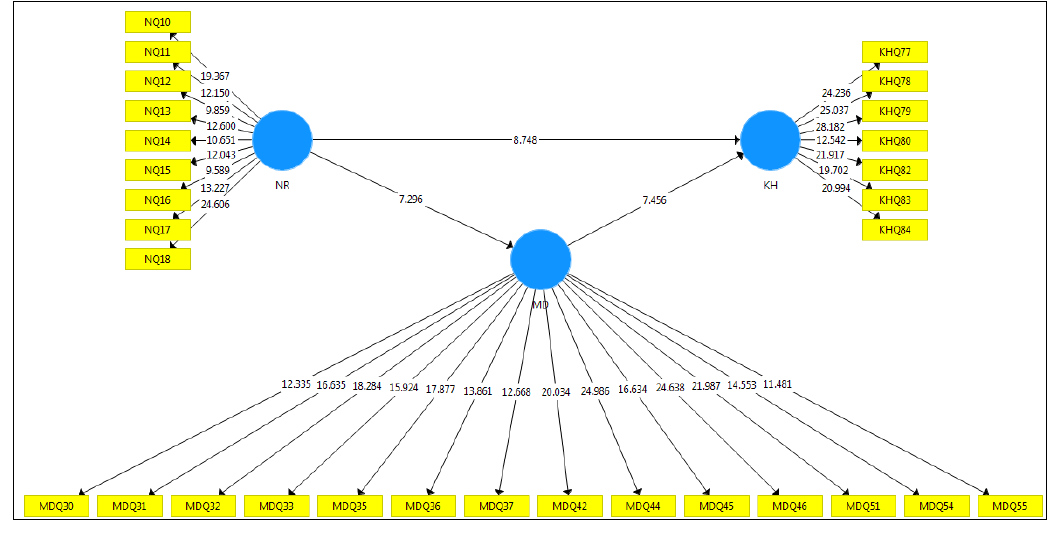
Figure.3: Structural